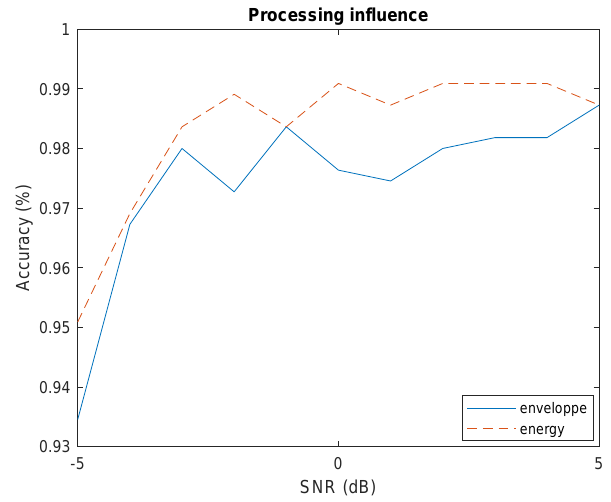
Figure 9. Influence of processing on accuracy.